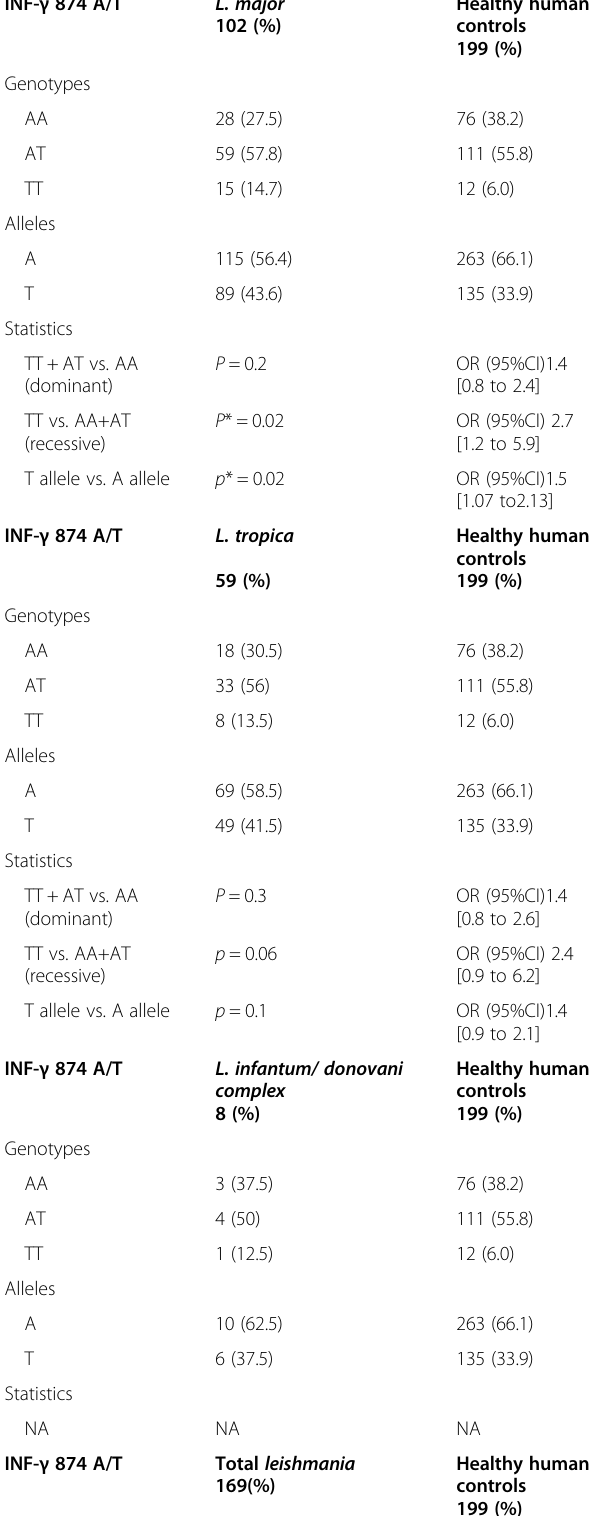
Table 4 Genotype frequencies of INF- γ + 874 A/T in different species of leishmaniasis and healthy human controls